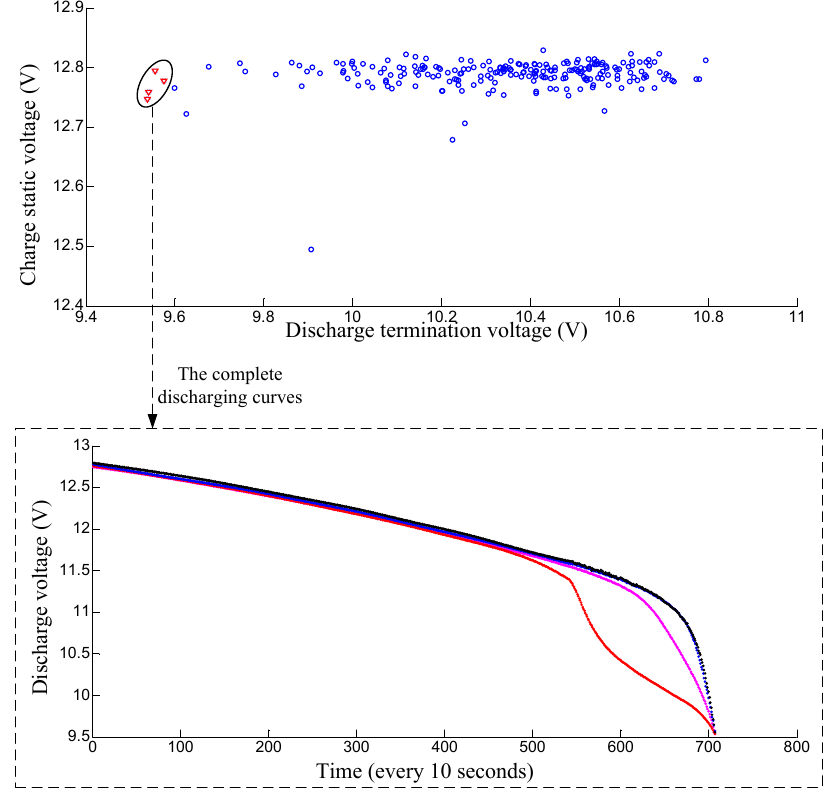
Figure 5. The first successful-grouping battery pack only using the charge static voltage and discharge termination voltage. Note that the full discharge curves of this battery pack have big